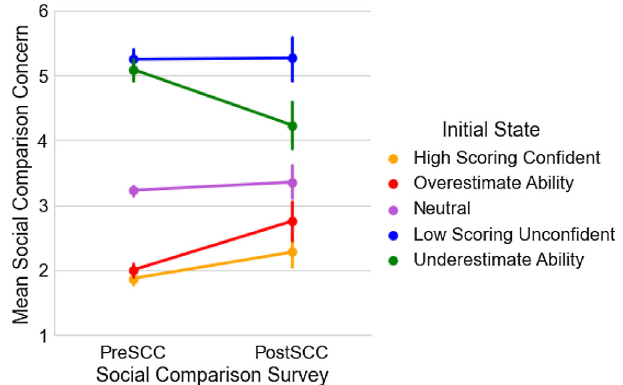
FIG. 4. Pre- and postsocial comparison concern for each of the five initial-state groups.